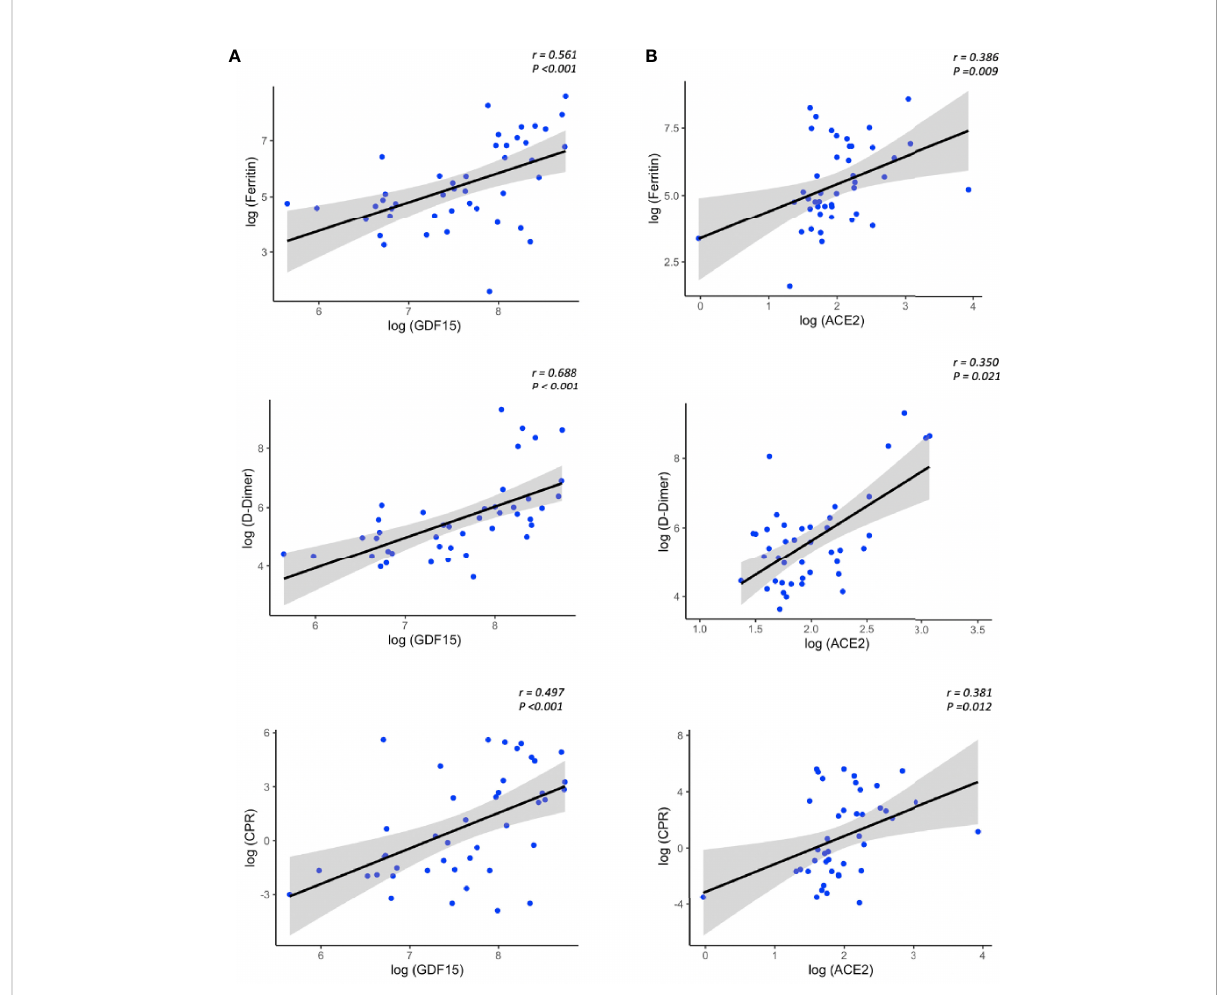
FIGURE 6 Representative scatterplots (spearman correlations) showing the association between GDF15 (A) and ACE2 levels (B) with classical in fl ammatory markers.The solid line represents the regression line. The grey shade represents the con fi dence